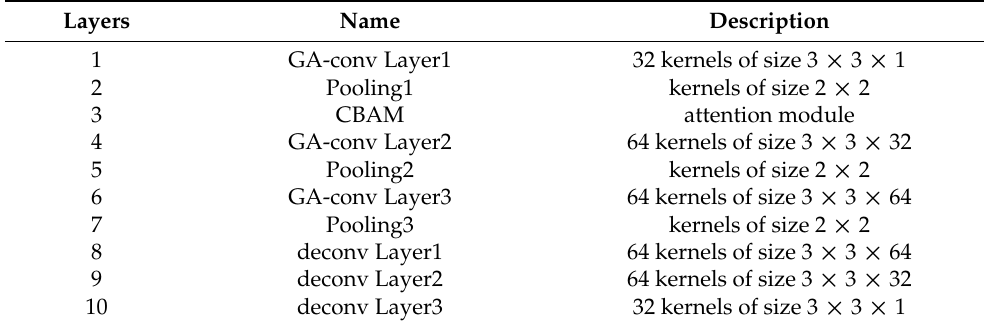
Table 2. Parameter configuration of the generator of